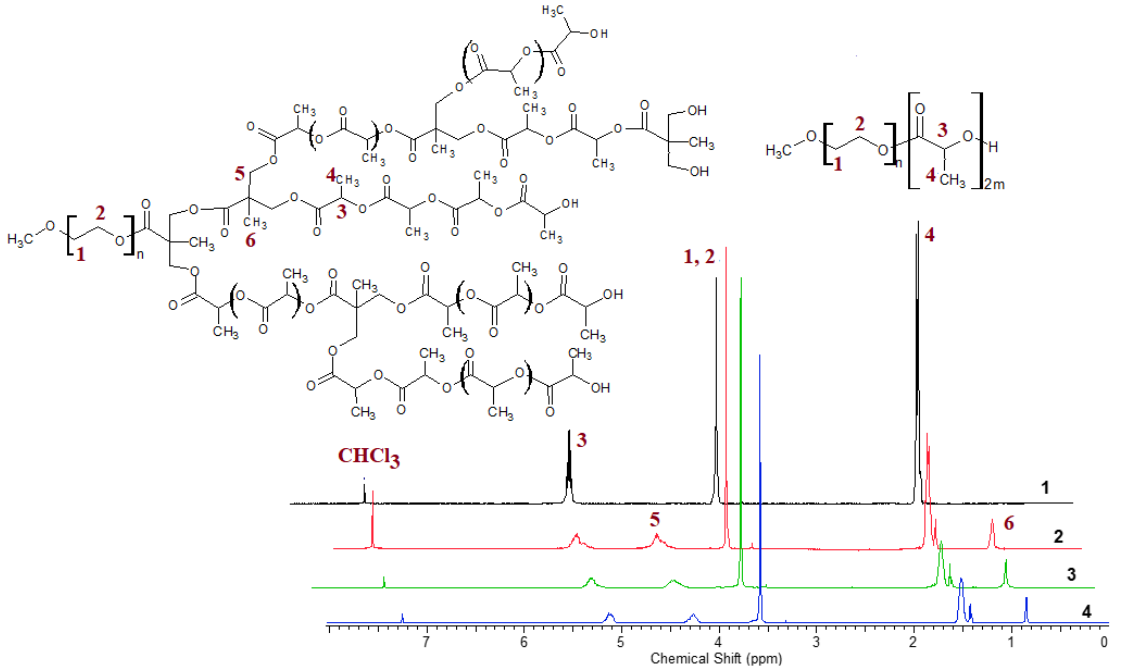
Figure 2. 1 H NMR spectra of synthesized polymers. The indices at the spectra correspond to the designations of the polymers in Table 1.